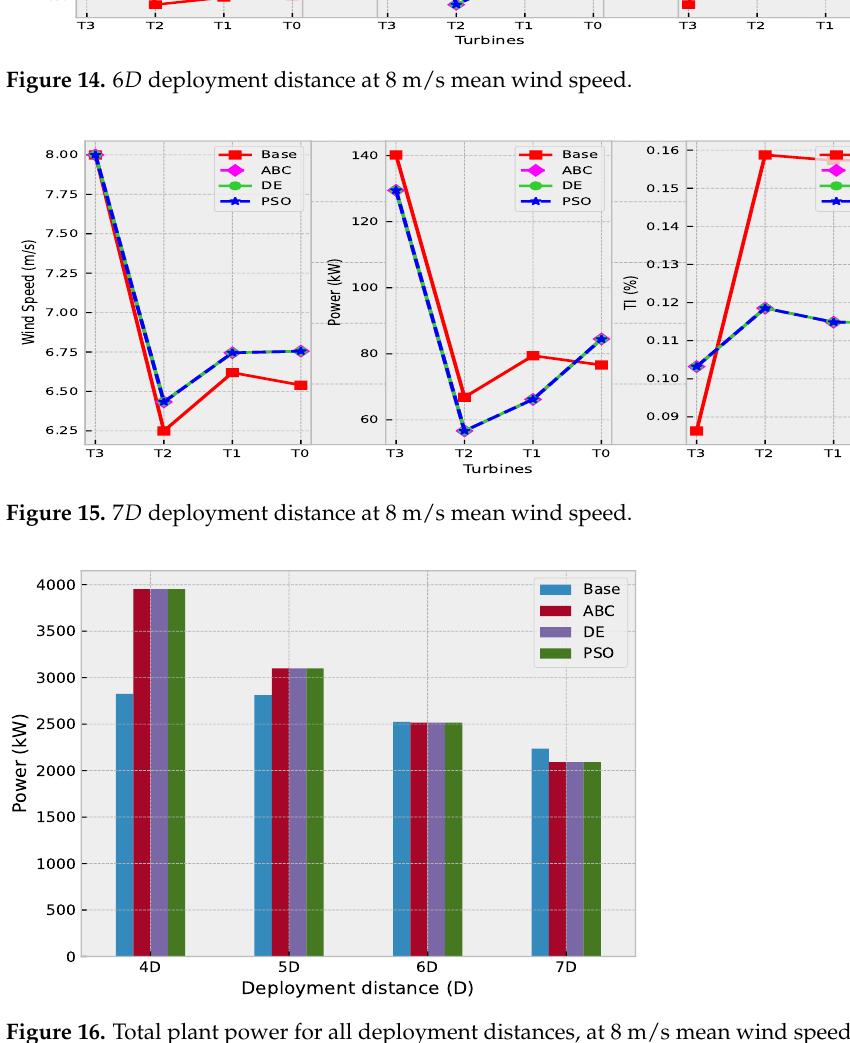
Figure 16. Total plant power for all deployment distances, at 8 m/s mean wind